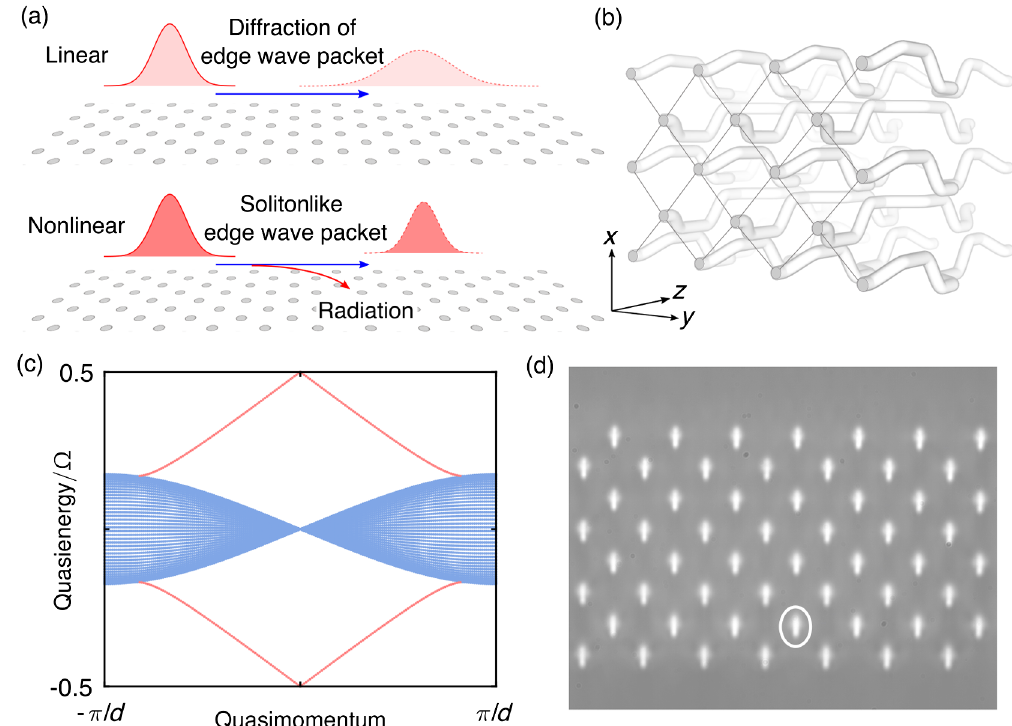
FIG. 1. Implementation of solitonlike edge states. (a) Unidirectional propagation of a wave packet along a linear topological insulator — because of the group velocity dispersion of the edge states, the edge wave packet diffracts (upper plot). The linear diffraction of the edge wave packet can be almost balanced by nonlinearity that arises from optical Kerr nonlinearity. Because of the discreteness, the solitonlike edge state radiates power along the edge and into the bulk at a finite and controllable rate (lower plot). (b) Schematic depiction of the implementation of a photonic Floquet topological insulator using a three-dimensional waveguide array. (c) Quasienergy spectrum of the bipartite photonic lattice ( δ ¼ 0 . 18 ) showing two ungapped bulk bands (blue) with zero net Chern number and chiral edge states (red). (d) Micrograph of the facet of a periodically driven square lattice consisting of 56 waveguides. A single-site input state, launched at the circled site on the zigzag edge, has a significant overlap with the topological edge